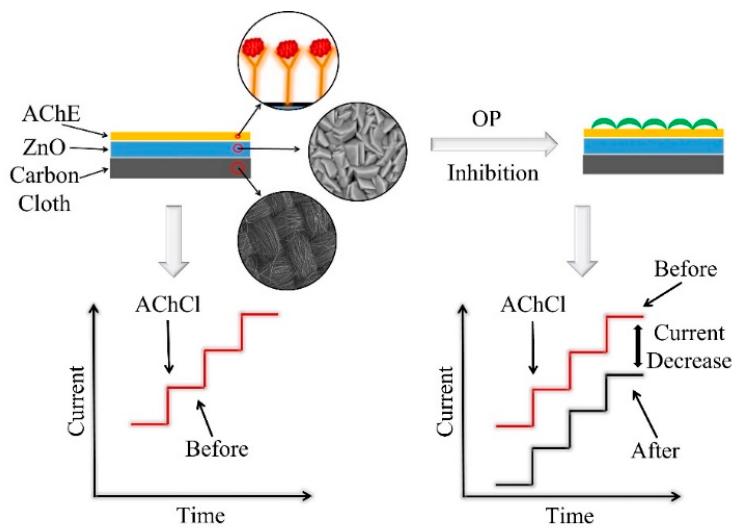
Figure 4. Schematic representing the mechanism adopted by the biosensor for the detection of pesticide.